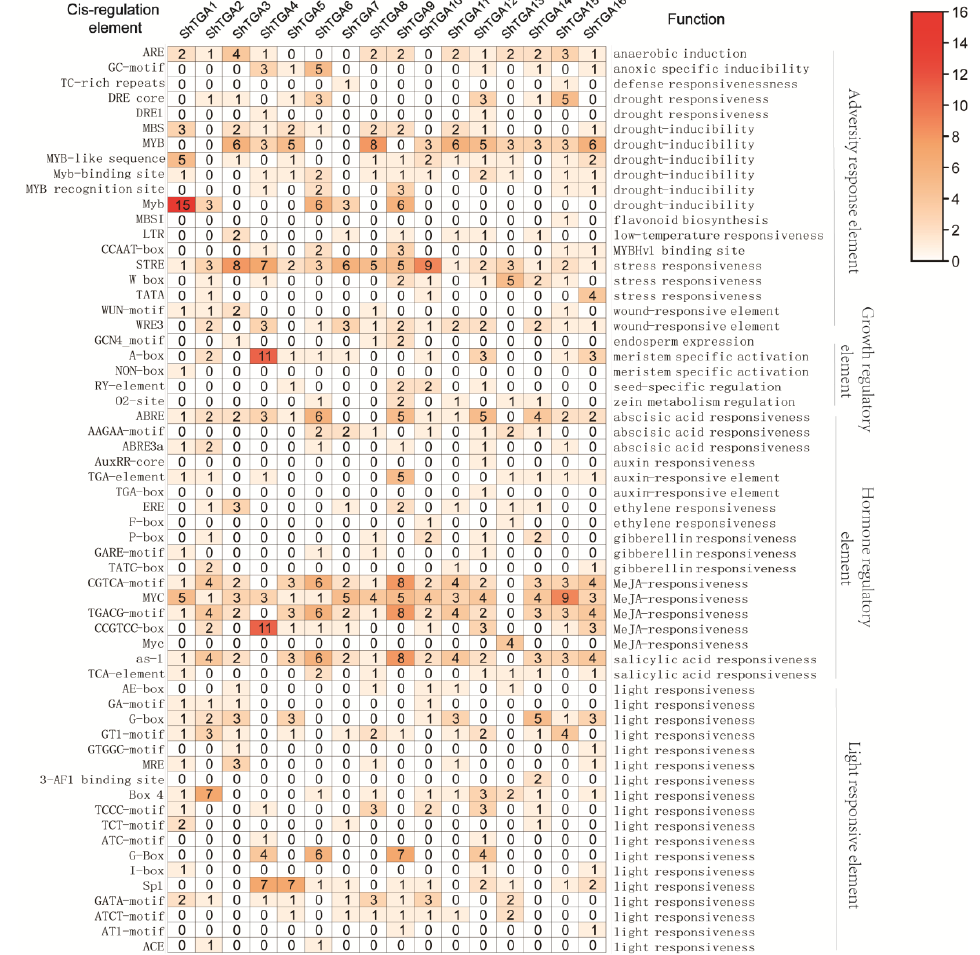
Figure 3. Number of varied cis-regulatory elements identified in the promoter regions from TGA family genes in sugarcane. Cis-regulatory elements related to hormone response, environmental stress and development were identified by Plant Promoter Analysis Navigator from PlantPAN 3.0 database, using 2000 bp upstream from the translation start site from each gene.